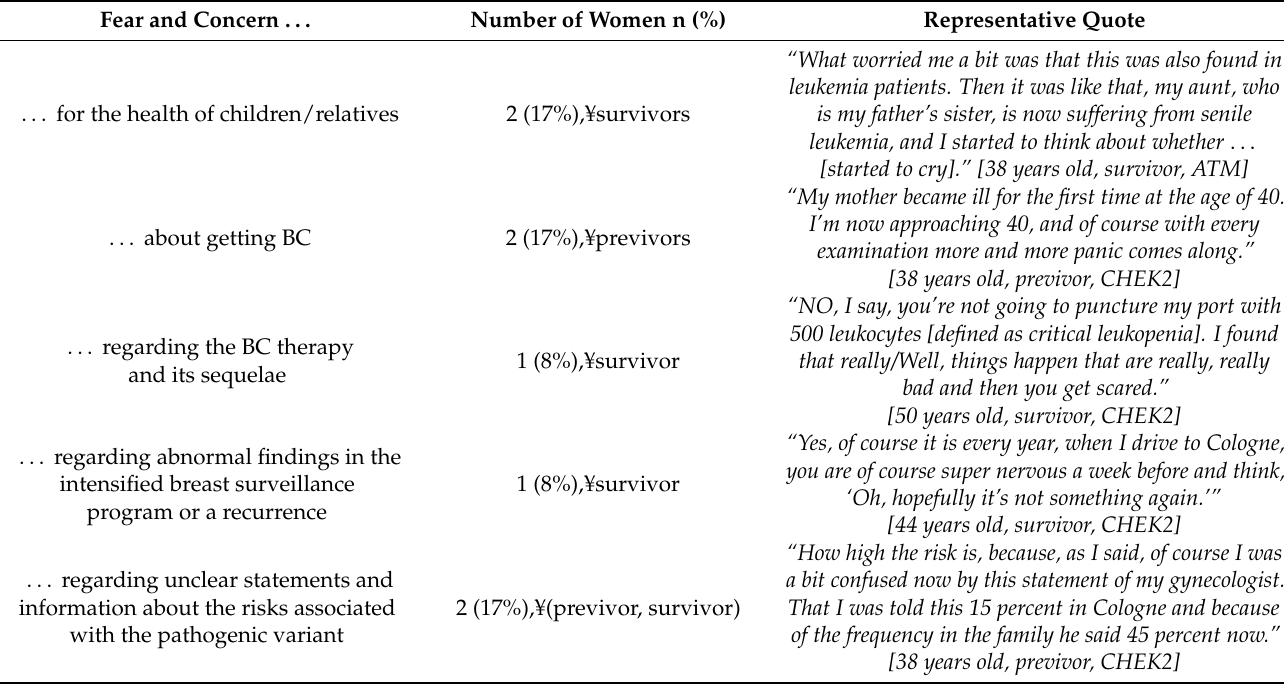
Table 4. Feelings associated with the overall situation: Fear and